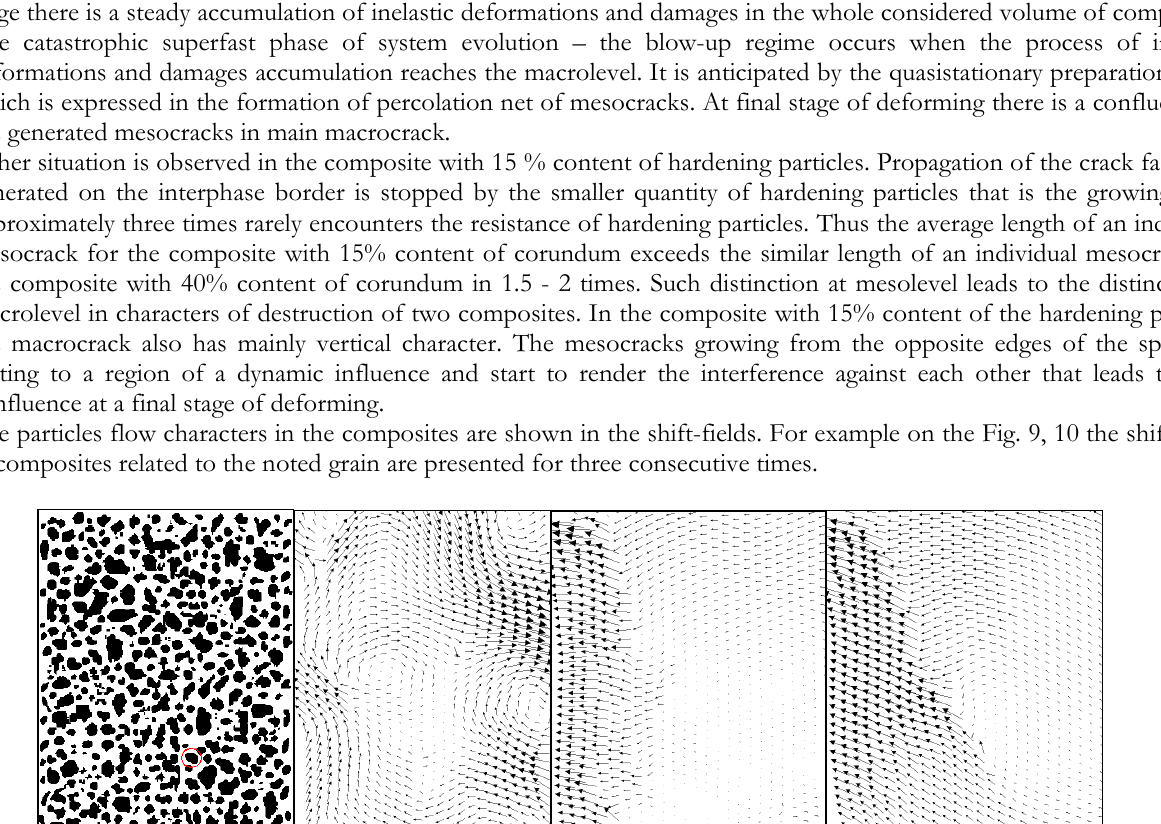
Figure 8: Simulation patterns: inelastic deformations (for three consecutive times), the stressed state ( composite specimen with 40% content of hardening particles in the case of friction on the loading border.